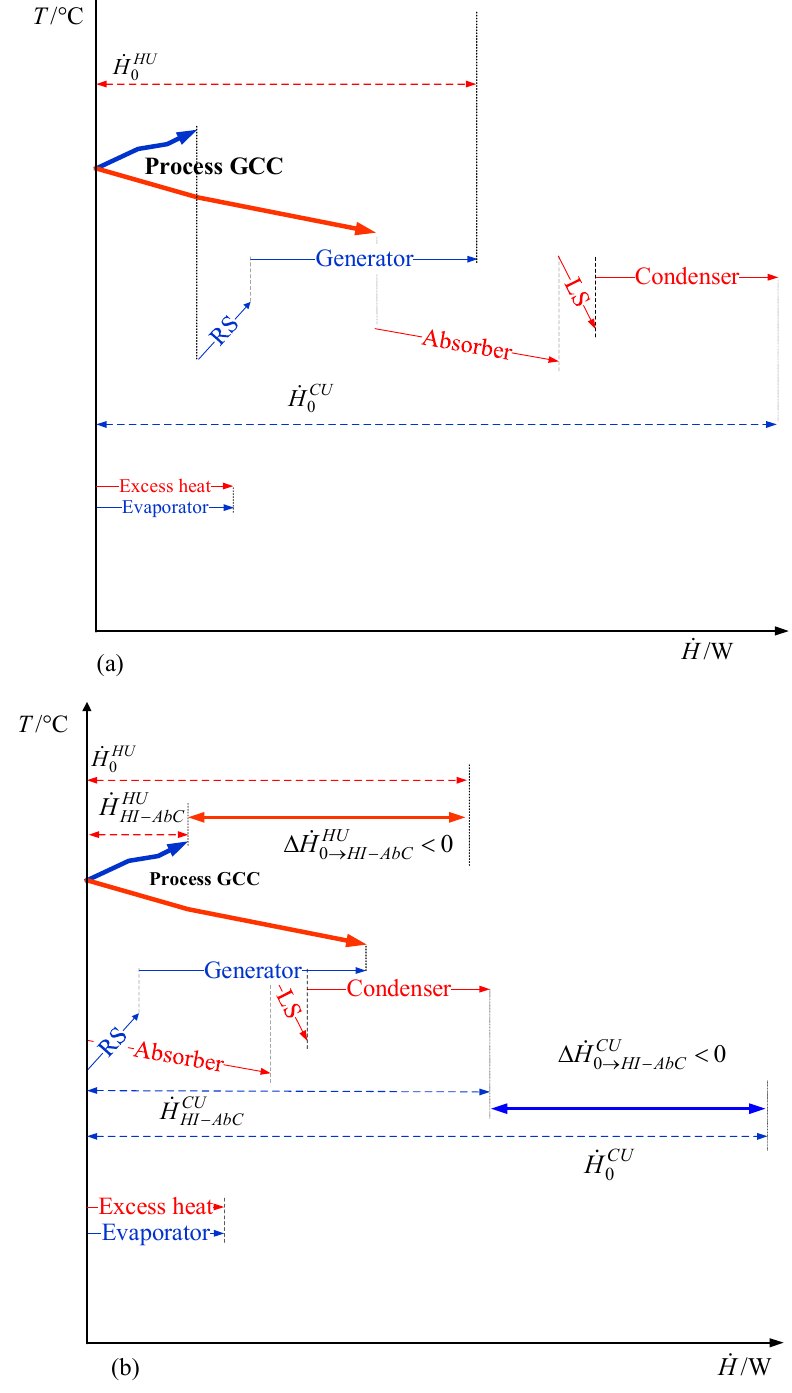
Figure 10. ( a ) Non-integrated and ( b ) integrated case of AC with process-integrating AC below the Pinch.